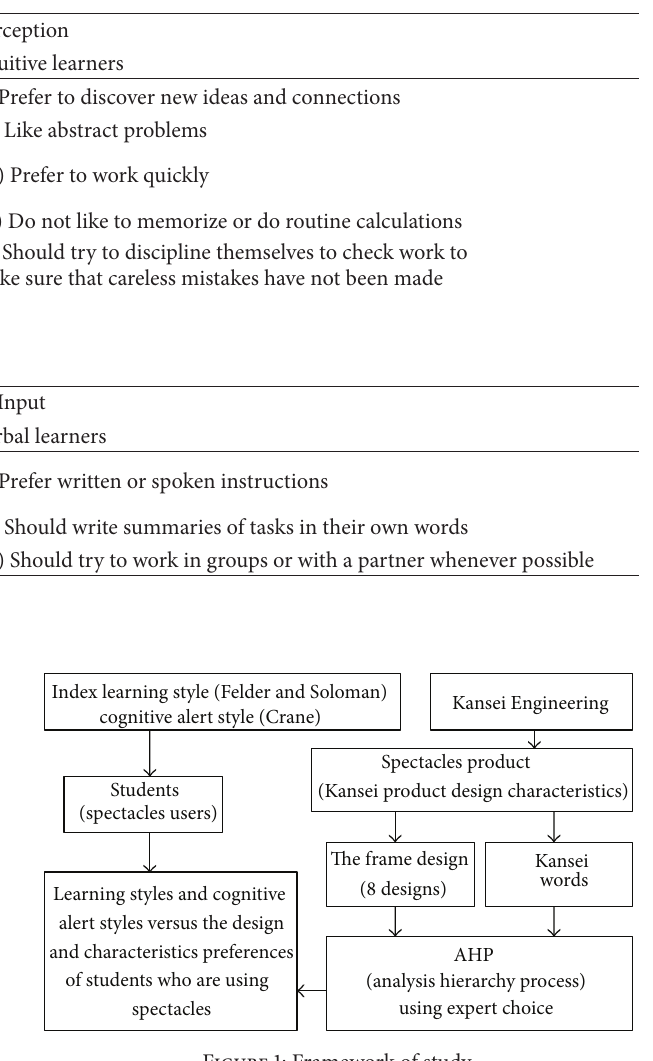
Figure 1: Framework of